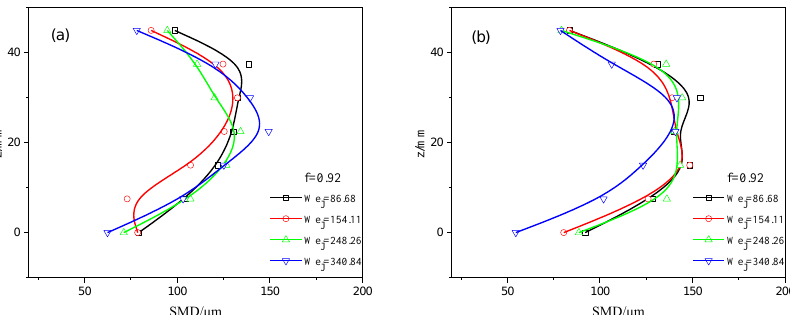
Figure11. Dropletsizedistributionalongthezdirectionfordi ff erentWe j atthesameWe g , ( a ) We g = 9.51, Figure 11. Droplet size distribution along the z direction for different We j at the same We g , ( a ) We g = ( b ) We g = 12.19. 9.51, ( b ) We g = 12.19.